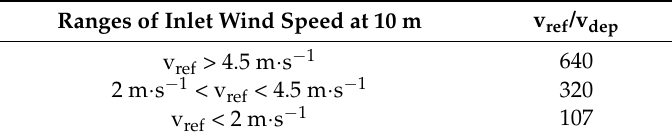
Table 2. Ranges of inlet wind speed at 10 m used in the WA CFD-RANS methodology. Ranges of Inlet Wind Speed at 10